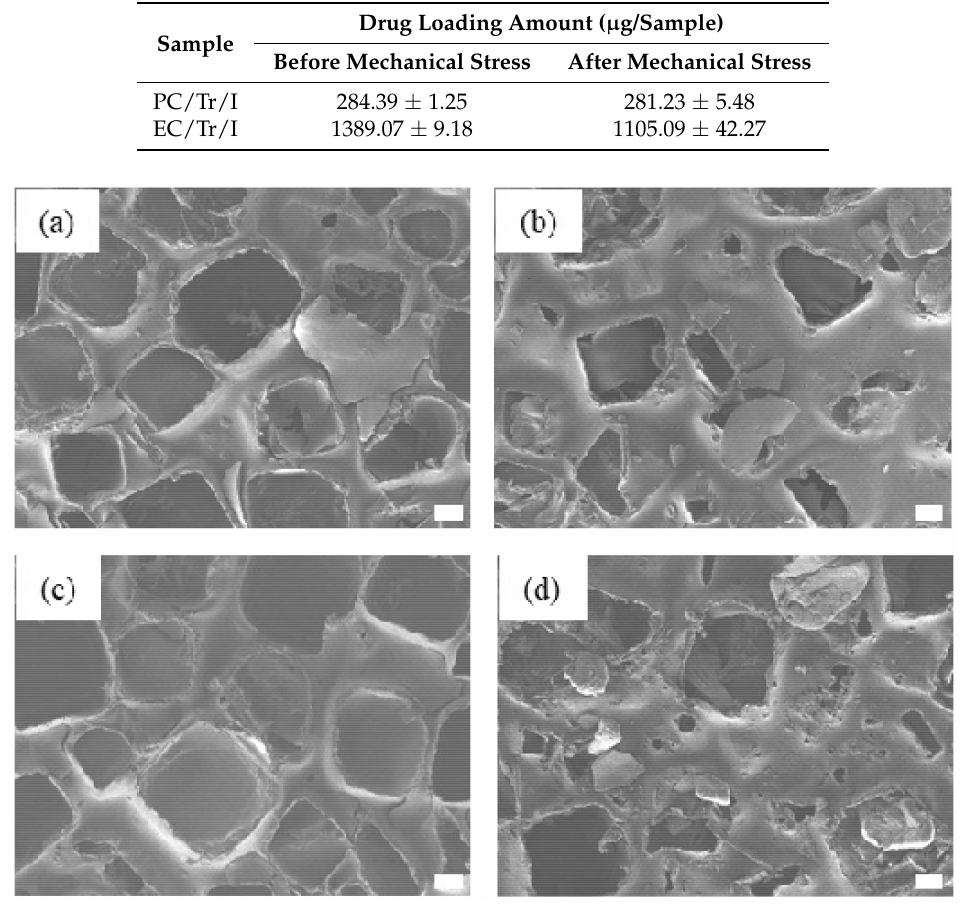
Figure 3. SEM images of the coatings before and after mechanical stress. The PC/Tr/I ( a ) before and ( b ) after mechanical stress and the EC/Tr/I ( c ) before and ( d ) after mechanical stress. Scale bars are 100 µ